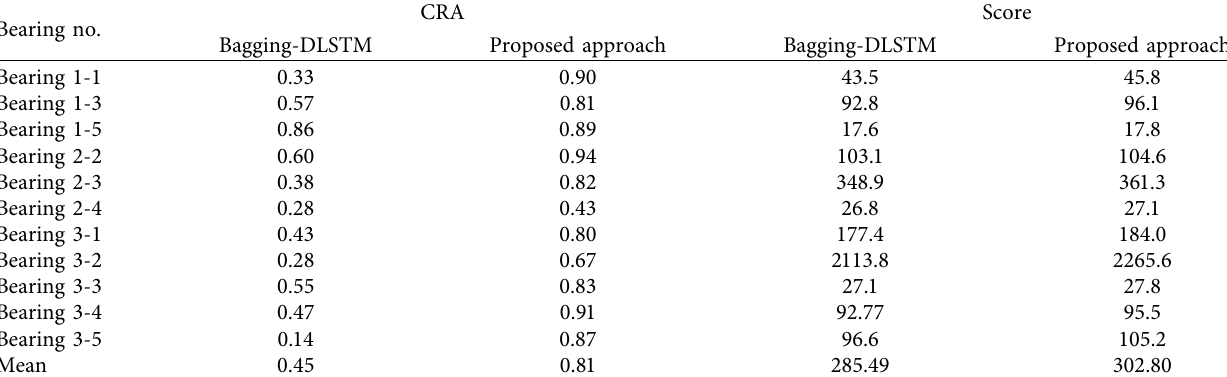
Table 8: Bagging-DLSTMpredicted metric